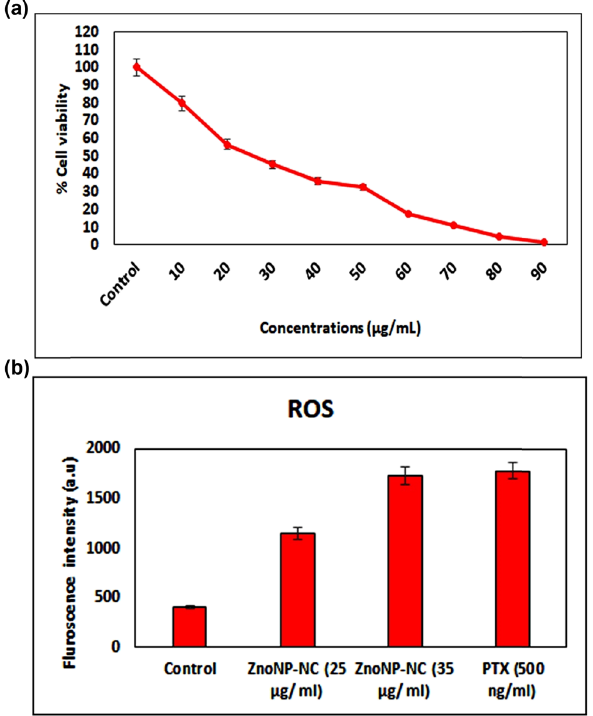
Figure 4: ZnONPs - NC induce signi fi cant cell toxicity and ROS pro - duction in SKOV3 cells. ( a ) The ZnONPs - NC - mediated cell death was evaluated by MTT assay. ( b ) ZnONPs - NC treatment - associated ROS production in SKOV3 cells was studied by DCFH - DA staining. Values from the plot are expressed as mean ± SD calculated by